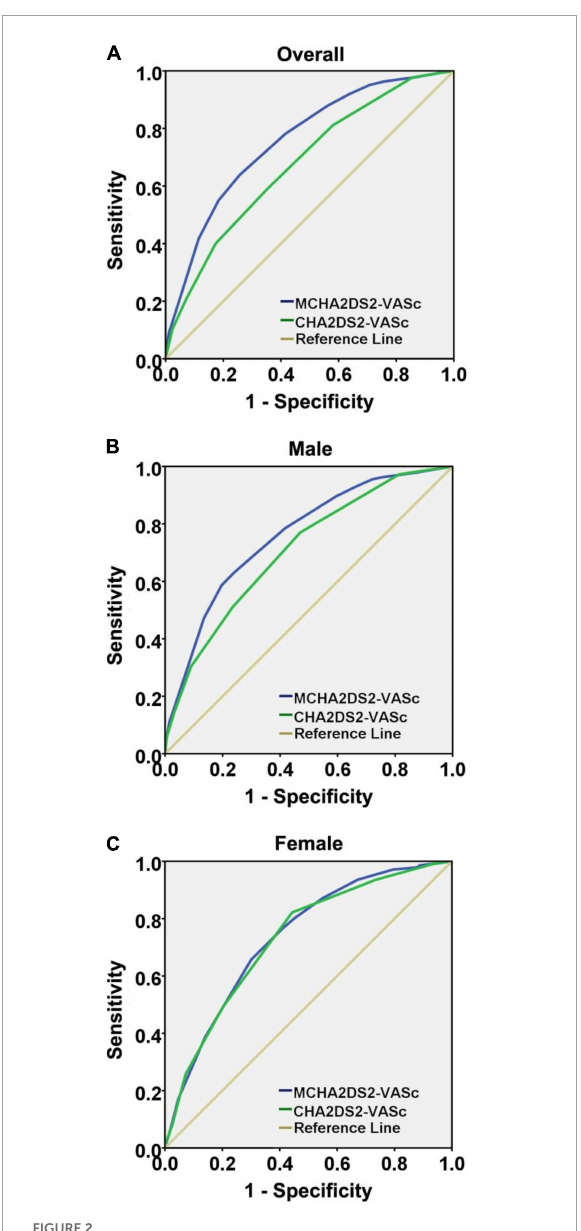
FIGURE2 Receiver operating characteristic curve analysis comparing CHA 2 DS 2 -VASc and MCHA 2 DS 2 -VASc scores’ ability to predict recurrent myocardial infarction, presented overall (A) , male sex (B) , and female sex (C)